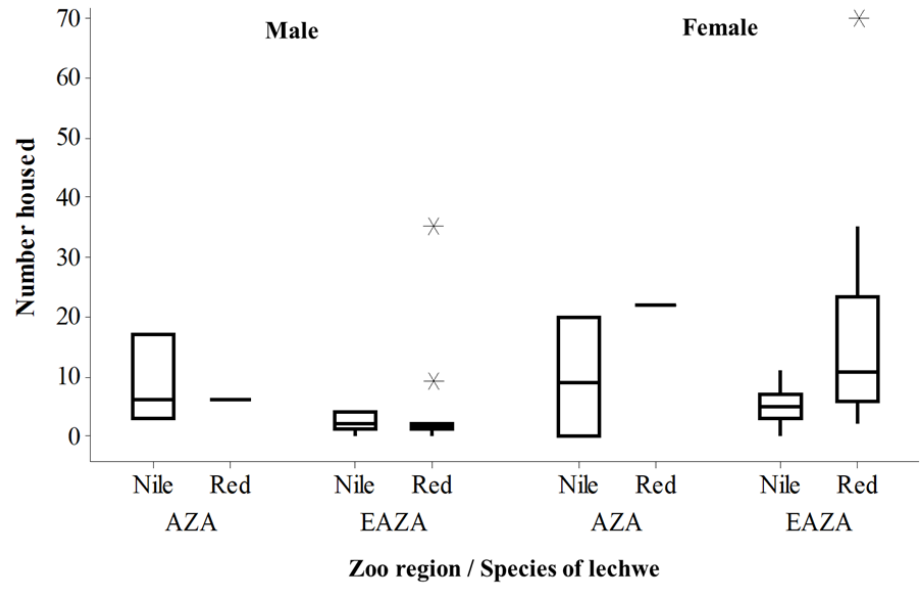
Figure 1. Comparison of number of male and female individuals in herds across EAZA and AZA regions for both Nile and southern (“red”) lechwe. Boxplot showing the median and interquartile ranges, as well as outliers (marked as